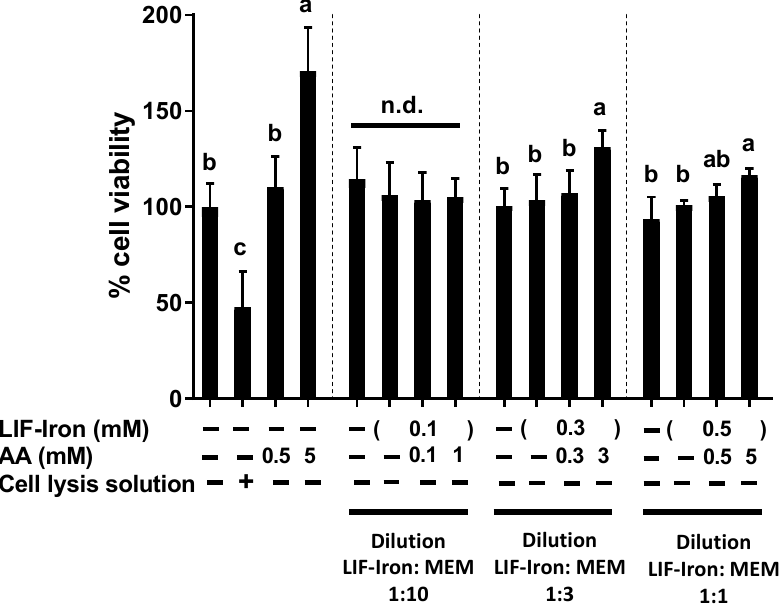
Figure 3. Effect of iron ingot (Lucky Iron Fish™ (LIF)) on cellular viability. Caco-2 cells were treated with the iron released from LIF (LIF-iron) plus the final indicated concentration of ascorbic acid (AA) diluted in MEM (LIF-iron:MEM, 1:10, 1:3 and 1:1) for 24 h. Data represent means ± SEM ( n = 8). Different letters indicate statistically significant differences ( p < 0.05). n.d. means not statistically different.